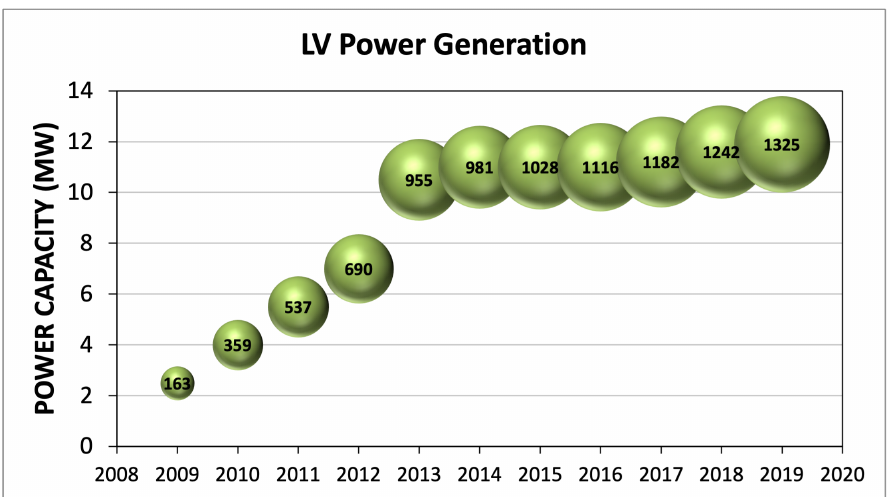
Figure 3. Number and capacity of the power generation plants connected to the MV lines from 2008 to